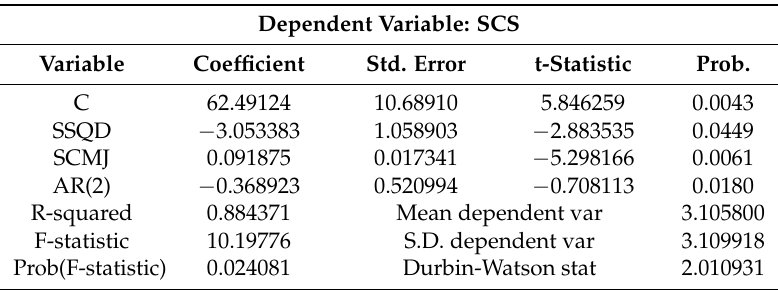
Table 9. Estimation of the aquaculture loss equation measurement model.